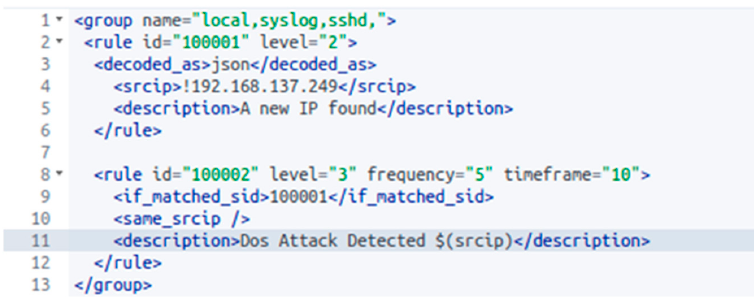
Figure 14. Dynamic Rules for DDoS Types Detection.